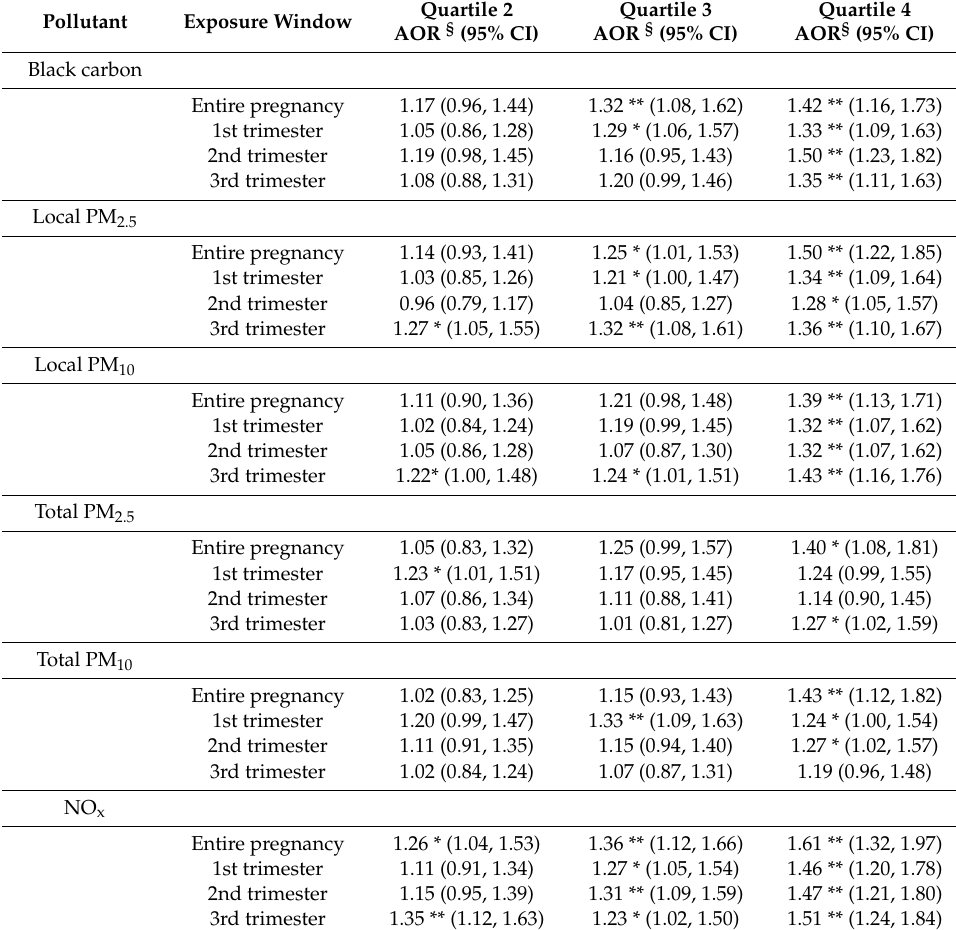
Table 3. Adjusted complete case analysis (CCA) for total preeclampsia in relation to the quartiles of all pollutants during each window of